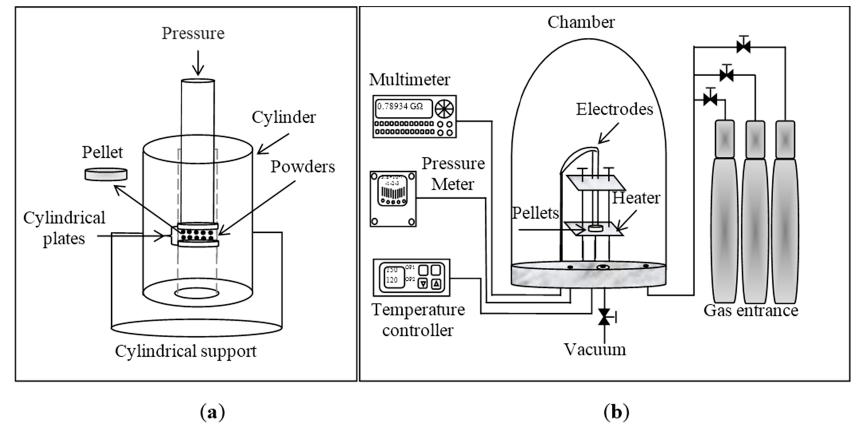
Figure 1. ( a ) Diagram of the device used to compact the powders of MgSb 2 O 6 oxide; ( b ) arrangement used for the sensitivity testing in controlled atmospheres and temperatures